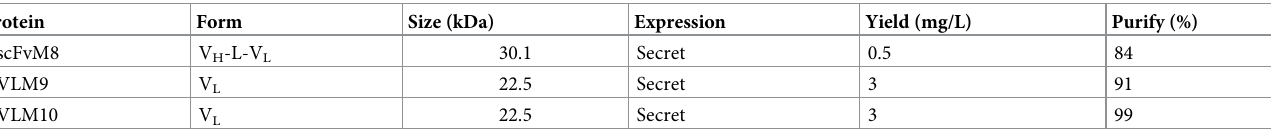
candidates were secreted into the media containing a signal peptide (PhoA or pelB). The expressed proteins were purified and verified using coomassie blue staining and western blot- ting with anti-6X His tag antibodies, which were tagged to the expression vector. The proteins, NscFvM8, NVLM9, and NVLM10, were successfully purified and displayed on the gel at 30.1, 22.5, and 22.5 kDa, respectively (Fig 3C). However, the yield and purity of each protein dif- fered. NscFvM8 was obtained at 84% purity with a 0.5 mg/L yield, NVLM9 at 91% purity and a 3 mg/L yield, and NVLM10 at 99% purity with a 3 mg/L yield (Table 3). The direct antigen binding affinity to the influenza virus particle H1N1/PR8 of the func- tional recombinant protein was assessed through indirect ELISA with a 2X serial dilution. ited concentration-dependent affinities. However, NVLM10 presented the highest interaction with H1N1/PR8, even at an OD value of approximately 0.5 (Fig 3D). NscFvM8 also showed 450 affinity to the influenza virions, however, the proteins were obtained at a low concentration (0.5 mg/L) and purity. Therefore, NVLM10 was chosen to engineer into a bivalent form with a linker to increase the candidate binding affinity to the virus, which is critical for antiviral activ- ity against H1N1/PR8 (Fig 4A). The bivalent NVL2M10 was expressed in a secreted form in BL21 (DE3) pLysE strains. It was also further purified and verified with coomassie blue stain- ing and detected using western blotting (Fig 4B) at a high yield of 3.5 mg/L with 98% purity. Table 3. Characterization of three candidates with purification yield.